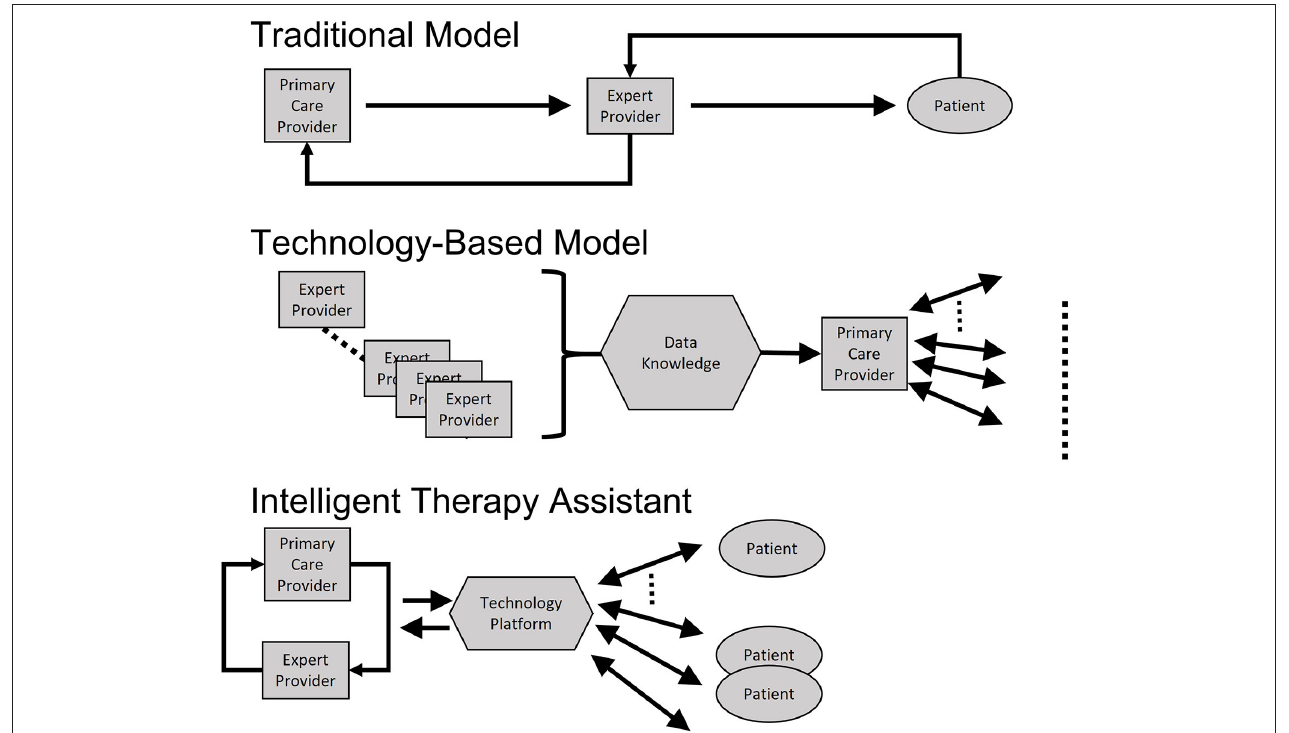
FIGURE 2 | Schematic illustration of Intelligent Technology Therapy Assistant (ITA) compared with traditional care model and more standard technology-based approaches. Traditional approaches require independent visits to primary care and specialists (expert providers). Technology based approaches consolidate expert knowledge and disseminates via primary care. ITA promotes the integration of knowledge from expert providers and primary care, using technology to disseminate the integrated knowledge to many patients. Importantly, the use of artificial intelligence enables the optimization of such knowledge, with inputs from specialists, primary care clinicians, and empowered